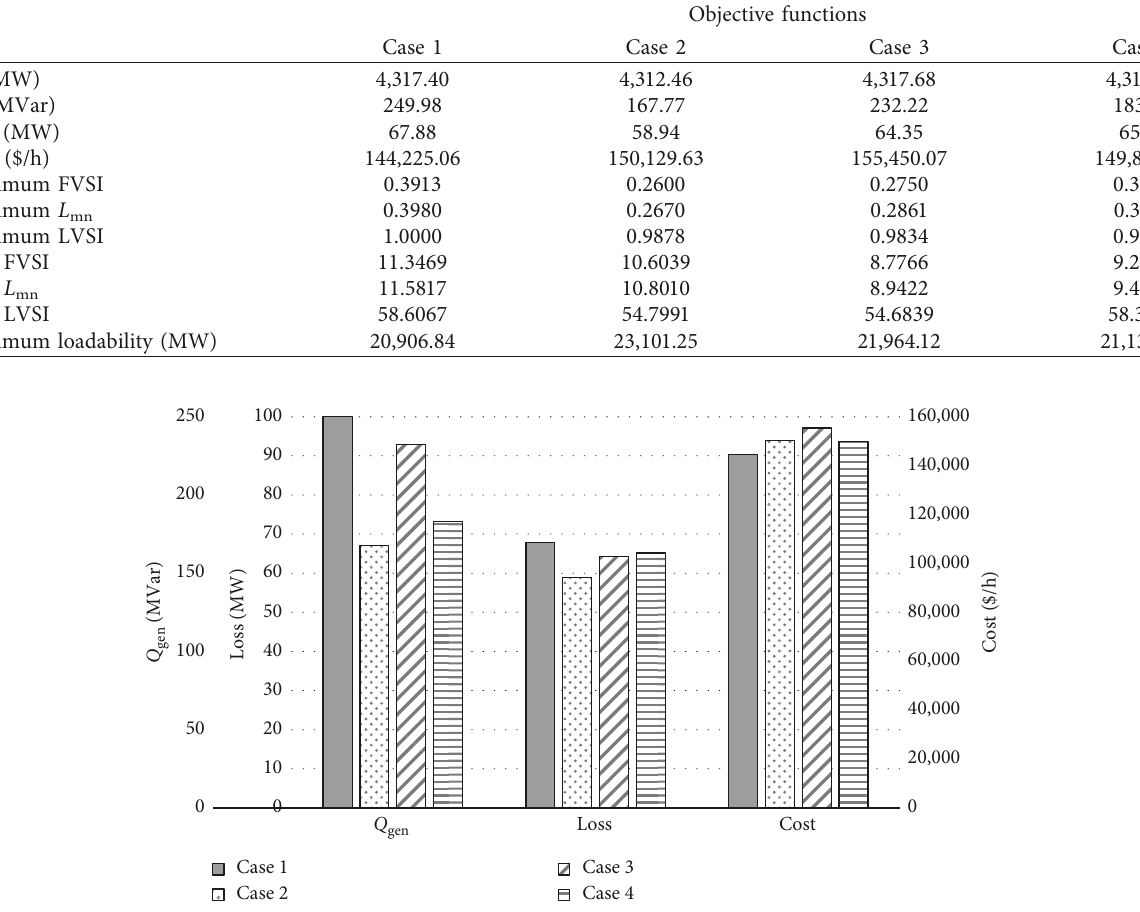
Figure 5: Variable comparisons for the IEEE 118-bus test